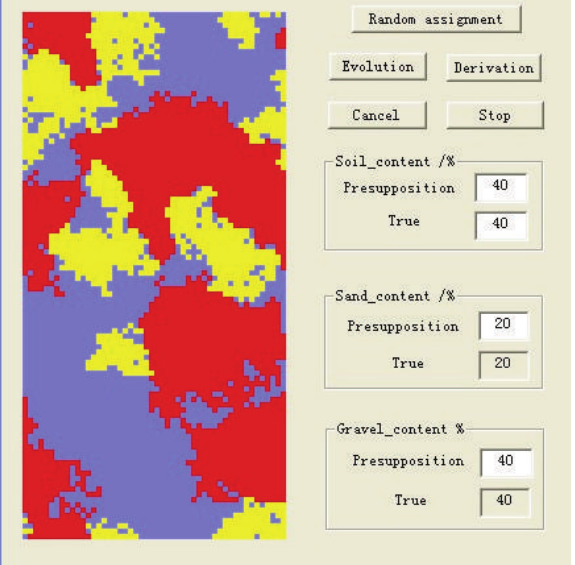
Figure 3: HHC-Granular model interface and generated granular